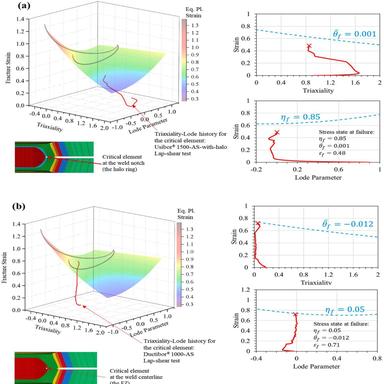
Predicted strain-stress state history of the critical element for (a) Usibor® 1500-AS-with-halo spot weld in lap-shear test, (b) Ductibor® 1000-AS spot weld in lap-shear test. Critical element for each case is shown in the inset finite element mesh.